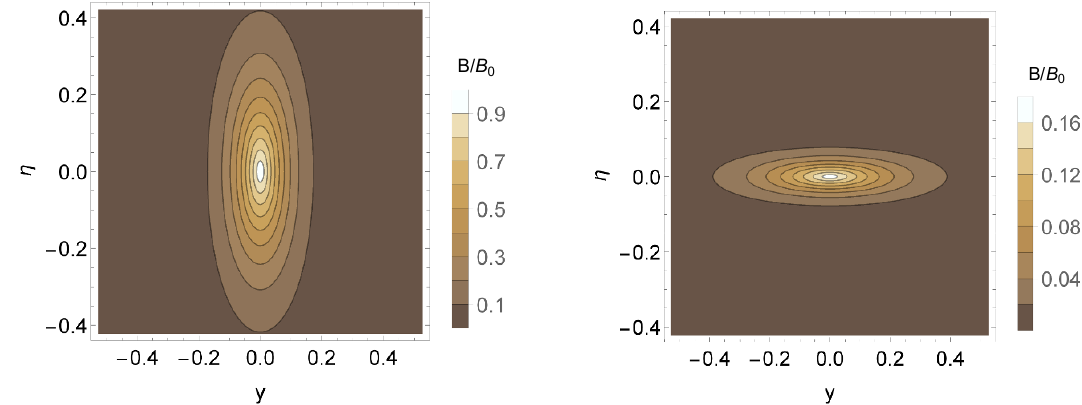
Figure 4 . (color online). The magnitude of the regularized magnetic (cid:12)eld in y (cid:0) (cid:17) plane using parameters (cid:12)xed in (6.7) for ! 1 = 0 : 5 ; ! 2 = 0 : 05 at (a) (cid:28) = 0 : 4 fm = c and (b) (cid:28) = 5 fm =